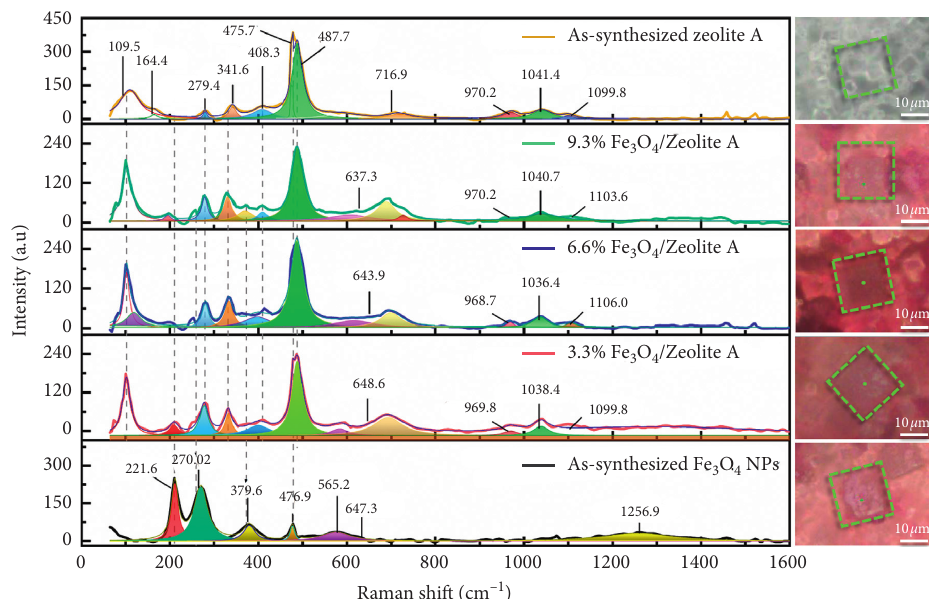
Table 1: Calculated crystallite size of the as-synthesized ZA and magnetic Fe Sample